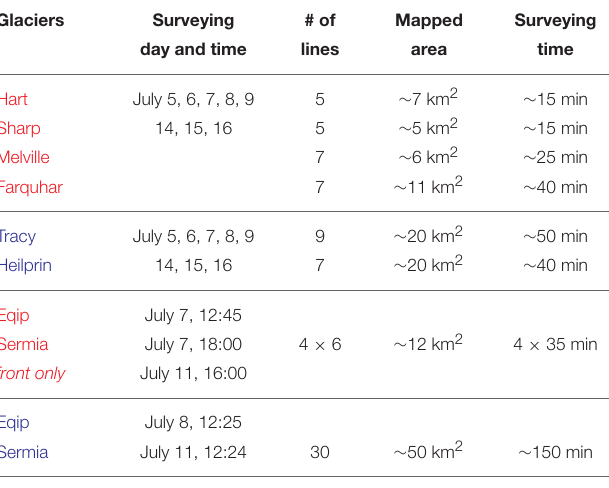
DEM differentiation were between 1 and 10 m, Figure